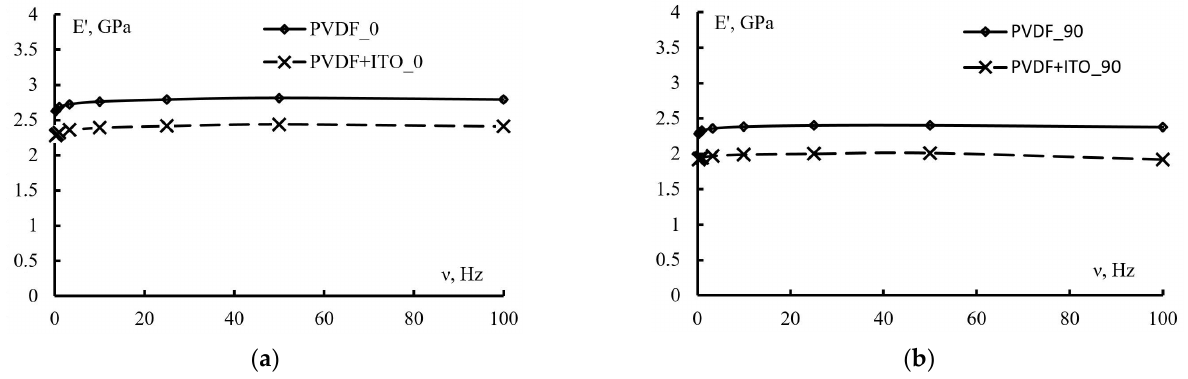
Figure 8. Variation of the elastic modulus E ′ in direction 0 (curve 1) and in direction 90 (curve 2) with increasing frequency v for the original and coated PVDF films in directions 0 ( a ) and 90 ( b ). Table 2 (E’ at a fixed frequency (50 Hz)) shows that elastic modulus differs by about 15% for the specimens tested in and across the orientational tensile direction. The coating decreased the elastic modulus by about 15%. At the same time, the di ff erence in the E ′ values for directions 0 and 90 remained at the same level.